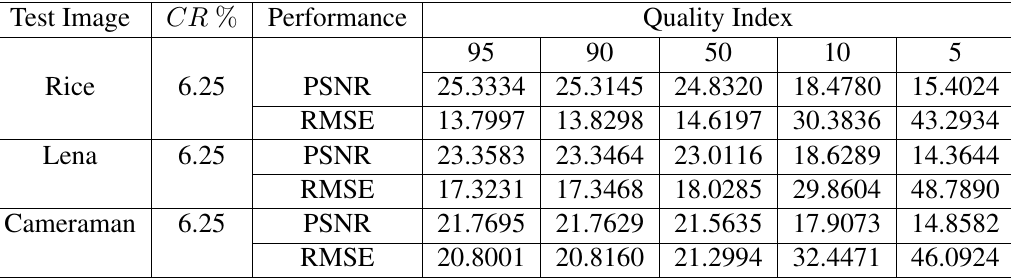
Table 3: Compression performance at different reconstruction qualities in the case of 4 × 4 blocks.